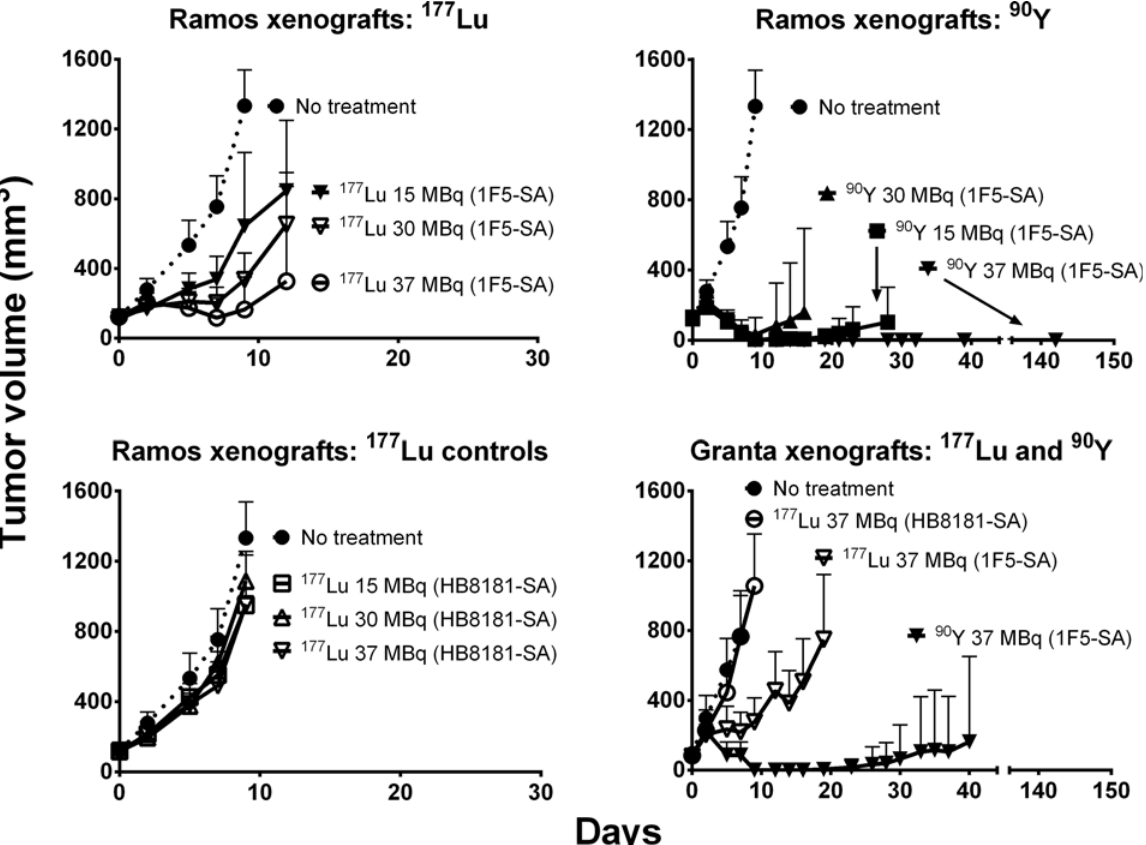
Fig 3. Regression of Ramos and Granta xenografts in athymic mice after either 177 Lu- or 90 Y-PRIT. Mice were injected with 1.4 nmol of 1F5-SA or HB8181-SA, together with 400 μ g of HB8181. Circulating MAb-SA was cleared by administration of 5.8 nmol of NAGB after 20 hours, followed by 15 – 37 MBq of either 177 Lu- or 90 Y-labeled DOTA-biotin (2.4 nmol) 4 hours later. Ten xenograft mice per tumor model served as control group (PBS only). The curves were truncated at the time of euthanasia of the first mouse in each treatment group (mm 3 ± SD; n =